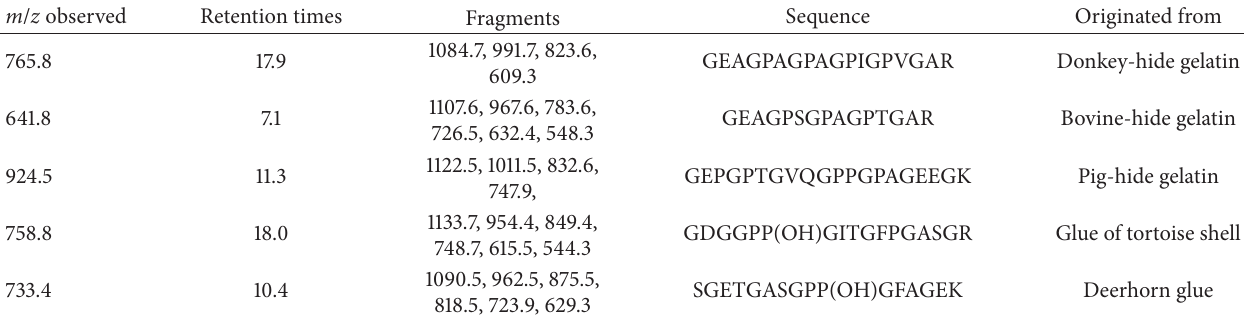
Table 1: Retention times and fragments of characterized species-specific peptides from each gelatin. m / z